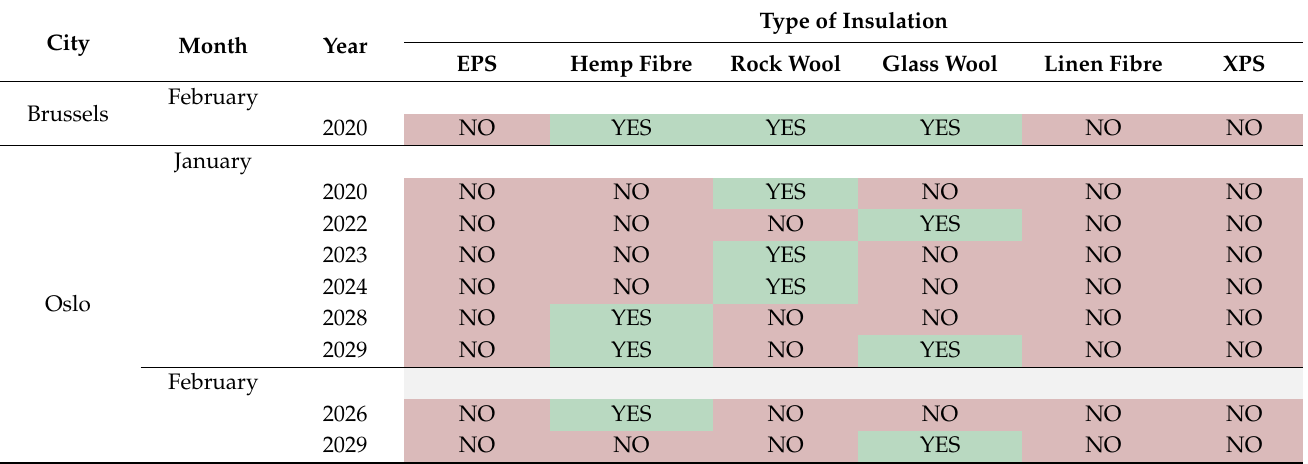
. The dispersion graphs in Figure 6 represent: (a) the trend of the average density of the insulation (kg/m 3 ) as a function of the quantity of IRH (%) and (b) the trend of the average density (kg/m 3 ) concerning the WCI (kg/m 2 ). The average density has been calculated considering the reference period in which the maximum IRH value occurs in the 10 years of simulation.